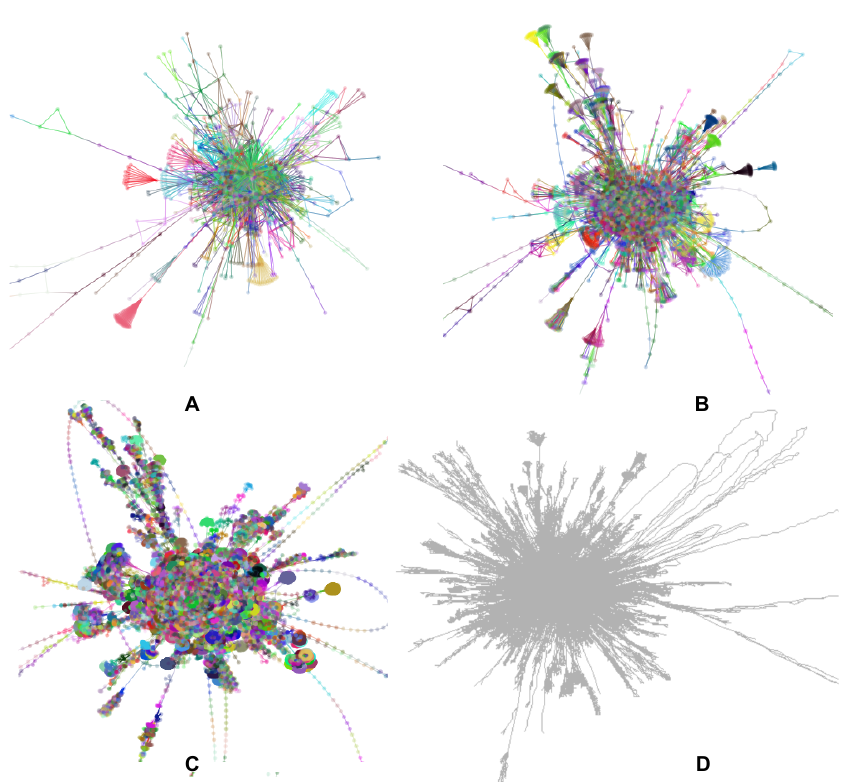
Figure 7. The web-Stanford layout results. ( A – C ) are three levels of coarsened graphs generated by our algorithm (graph nodes colored by cluster membership); ( D ) is the result from FM 3 implemented by ODGF